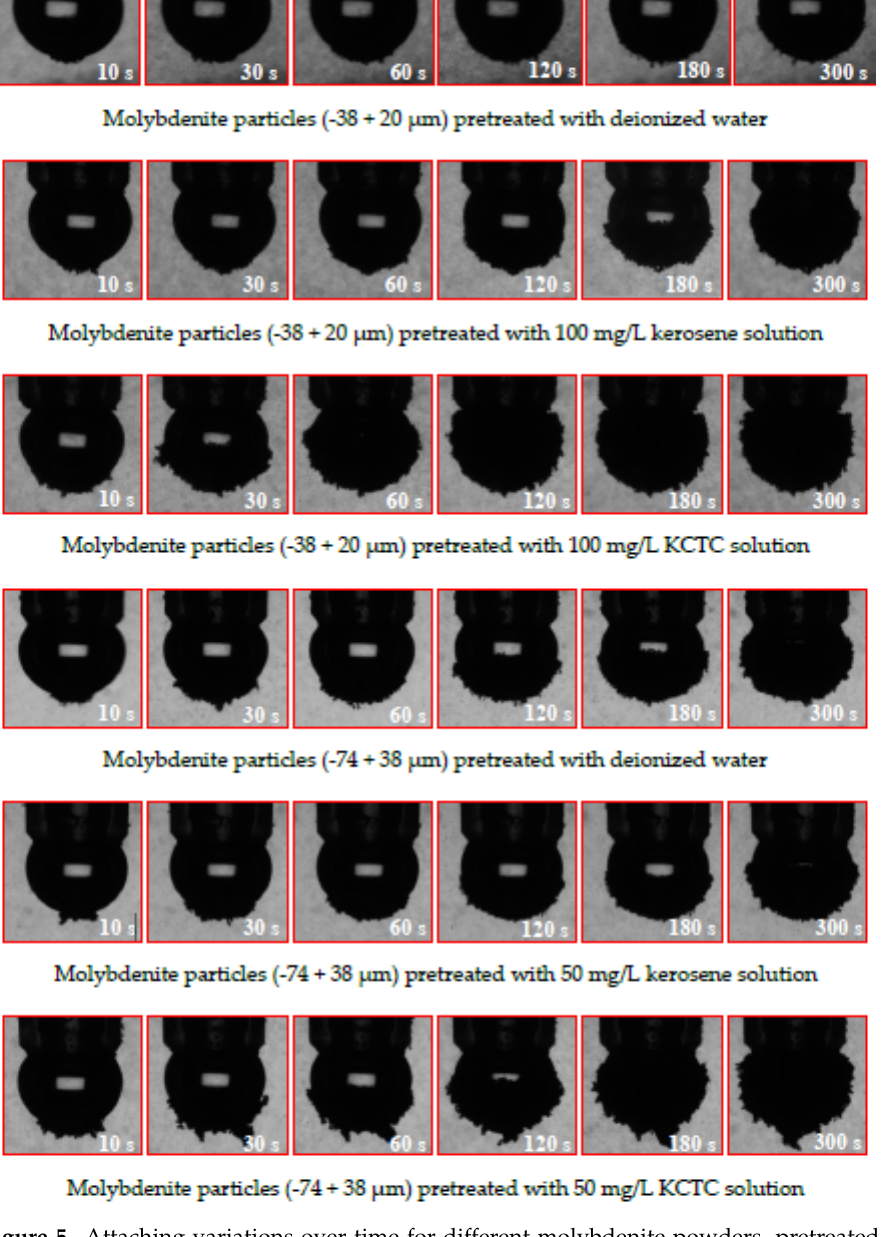
Figure 5. Attaching variations over time for different molybdenite powders, pretreated with or without collectors.